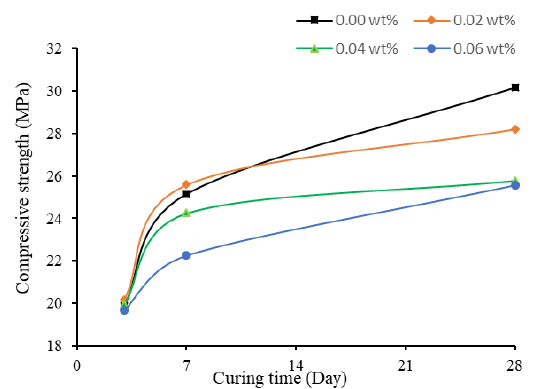
Figure 2. Compressive Strength of No TX10 contained mortar cubes.